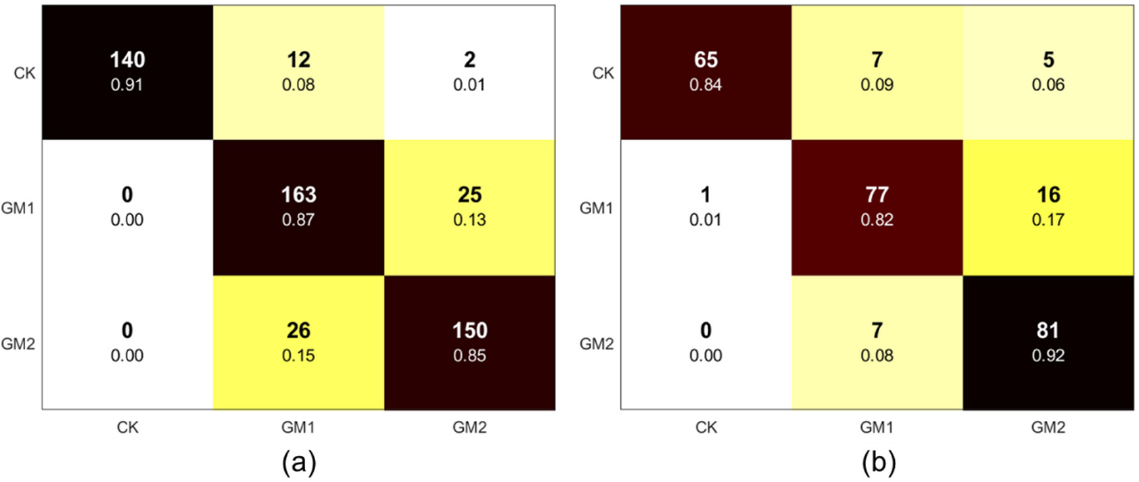
Figure 6. Confusion matrices of the training set ( a ) and the prediction set ( b ) for the BPNN model established by feature bands of GA.